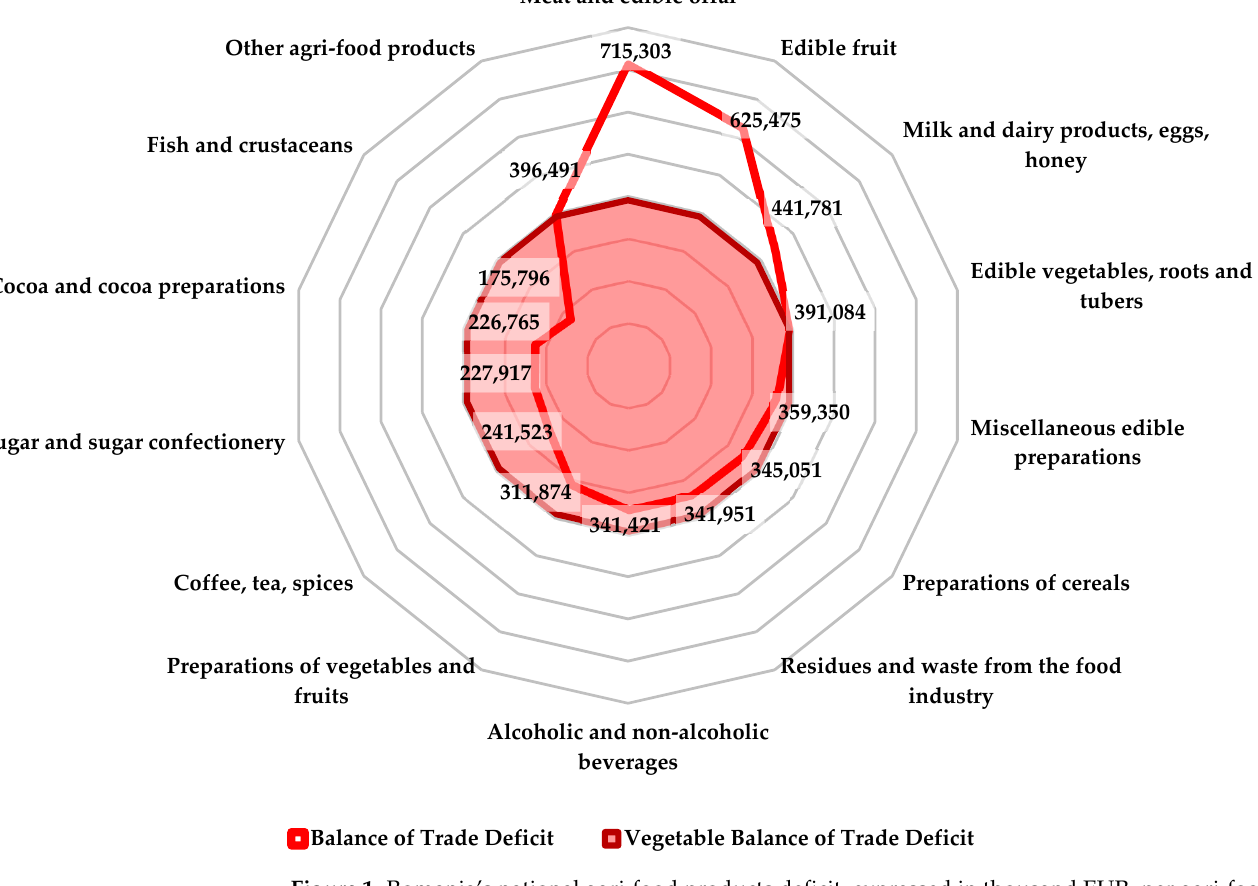
Figure 1. Romania’s national agri-food products deficit, expressed in thousand EUR, per agri-food category, in 2020. Source: authors’ own graphical representation.